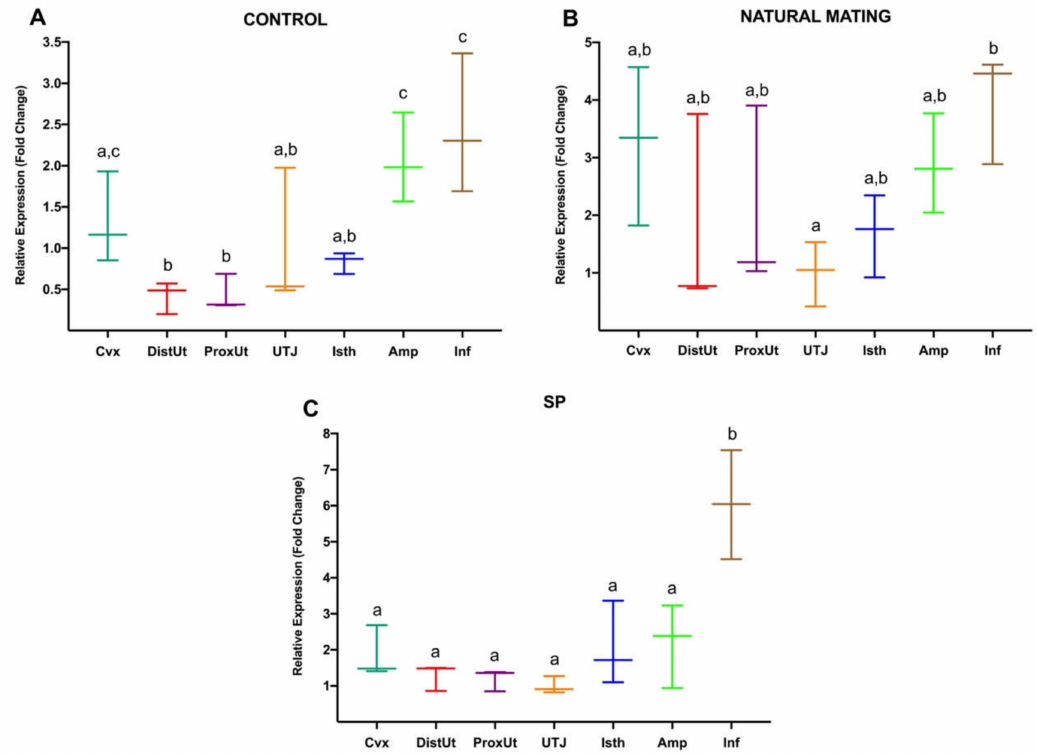
Figure 2. ( A – C ). Gene expression di ff erences of NR3C1 between anatomical segments (cervix, Cvx; distal uterus, DistUt; proximal uterus, ProxUt; utero-tubal junction, UTJ; distal isthmus, Isth; ampulla, Amp; infundibulum, Inf) in negative control group ( A ), natural mating ( B ), and sperm-free seminal plasma infusion (SP) ( C ). Di ff erent letters indicate values that di ff ered significantly between anatomical regions in the same treatment ( p < 0.05). The expression was relativized using the UTJ as a reference. Median (minimum,